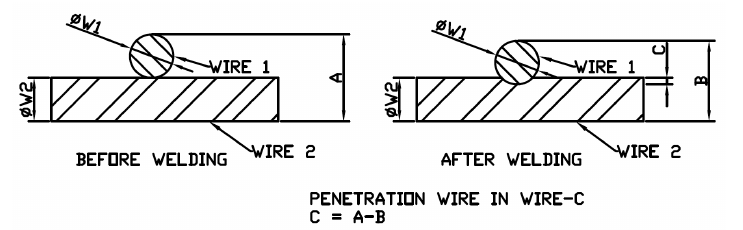
Figure 6. Penetration of wire 1 in wire 2 after welding.